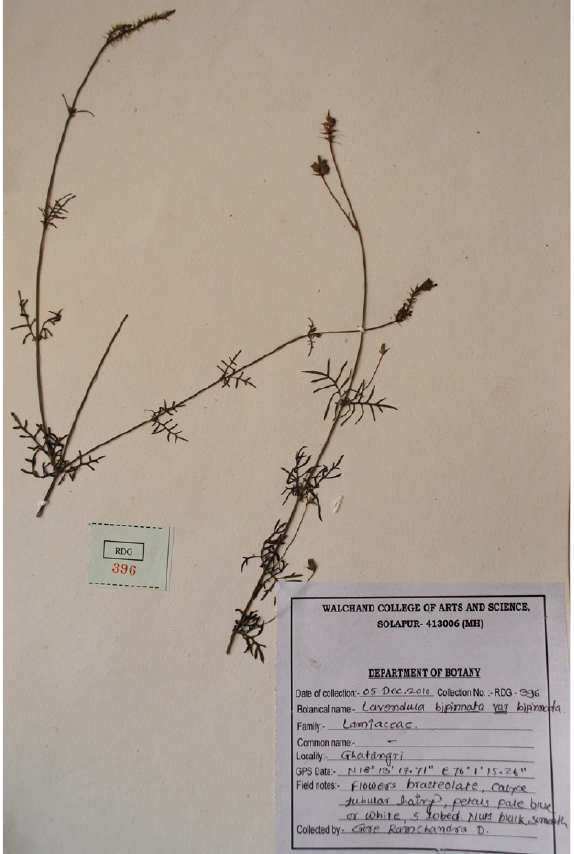
Image 18. Lens cullinaris